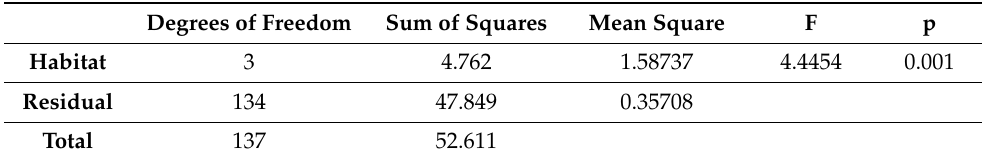
Table 5. Results of the PERMANOVA assessing the null hypothesis of no significant difference in fish communities among the four habitat types: sand, low relief rock, moderate relief rock, and high relief rock.